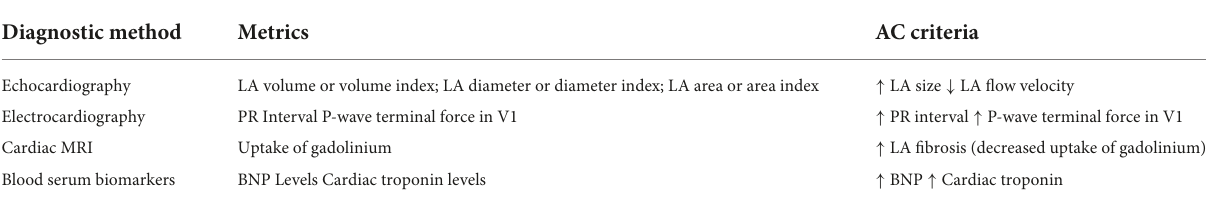
TABLE 1 Proposed diagnostic criteria for